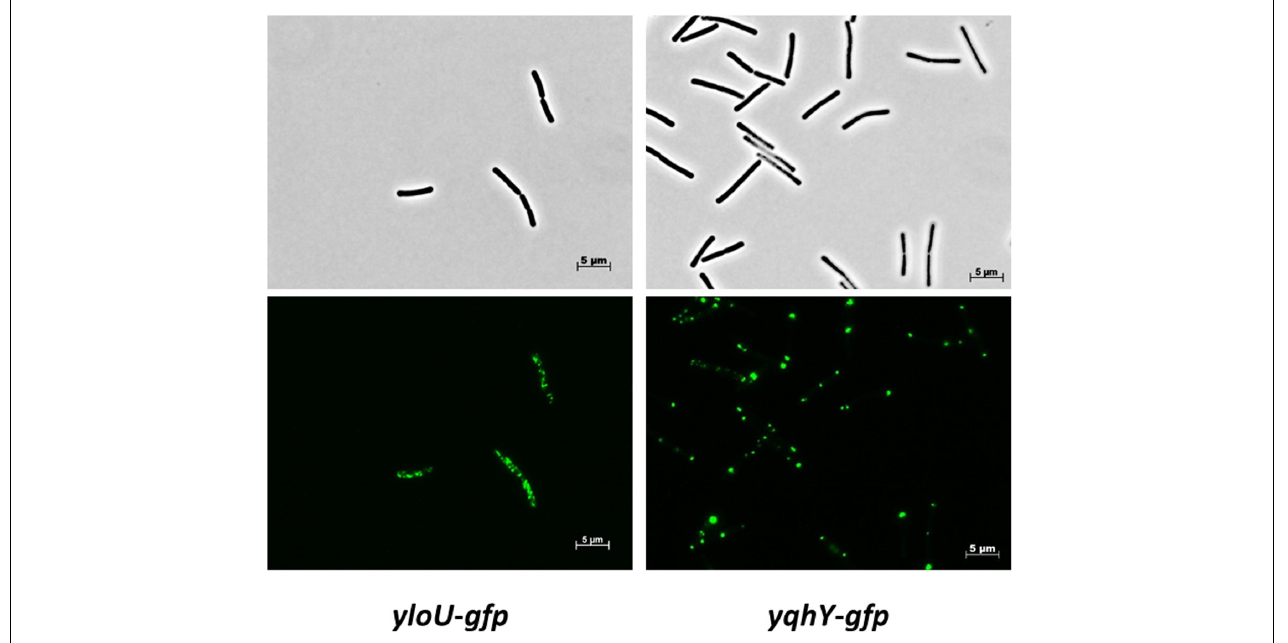
FIGURE 2 | Localization of YloU and YqhY. The proteins were fused to a monomeric GFP at the C-terminus and visualized via fluorescence microscopy.